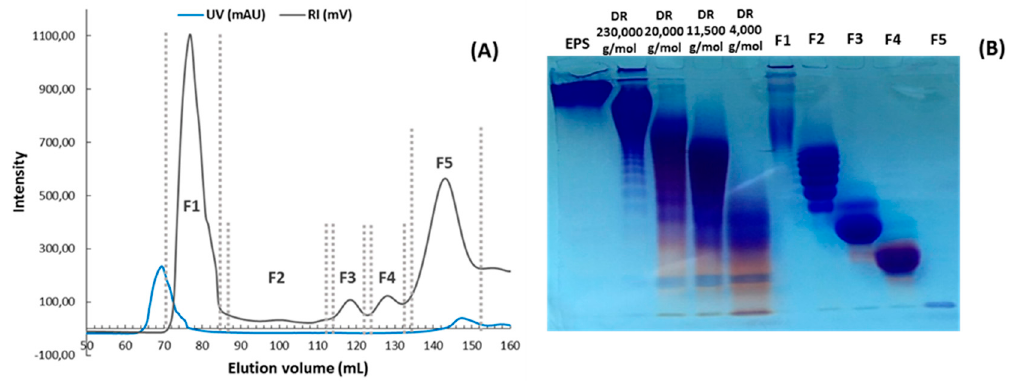
Figure 5. SEC fractionation of the native GY785 EPS depolymerized with cell debris, D for 63 h; UV and RI detections are indicated in blue and grey, respectively ( A ). PAGE analysis of the native GY785 EPS, four EPS derivatives with the weight-average molecular weight of 4000, 11,500, 20,000 and 230,000 g / mol, respectively, and five SEC fractions obtained after the GY785 EPS incubated with cell debris ( B ).